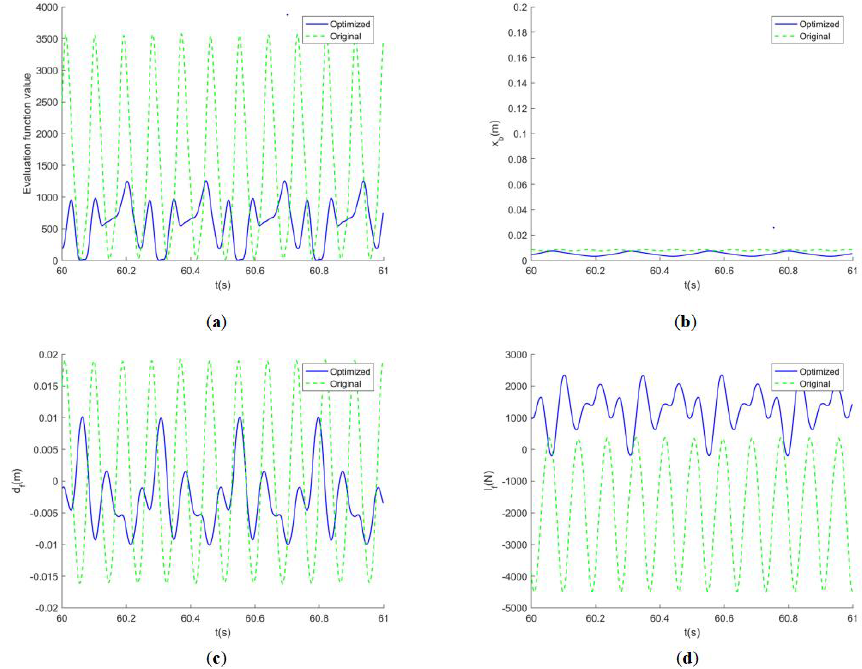
Figure 10. Comparison of system response curves of each parameter of the active suspension vehicle before and after optimization. (a) Ob- jective function F . (b) The vehicle body’s vertical displacement. (c) The front suspension’s dynamic deflection. (d) The front wheel’s dynamic